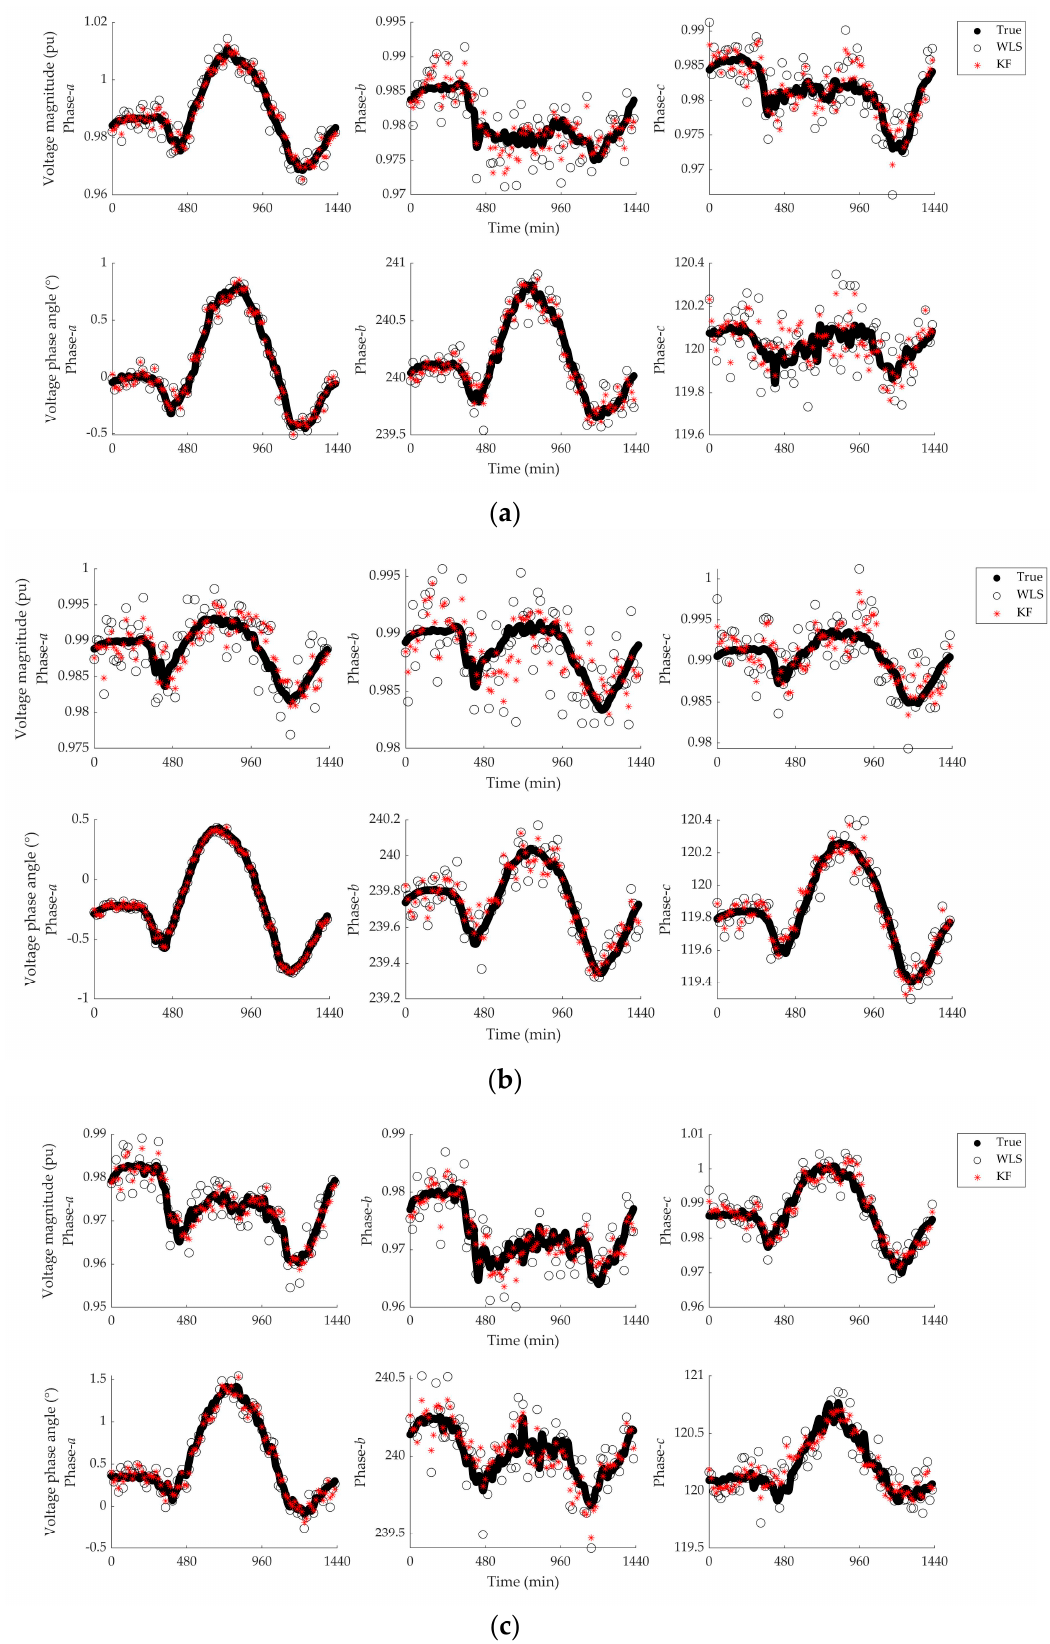
Figure 5. Estimated state values at buses ( a ) 5, ( b ) 11, and ( c ) 41.